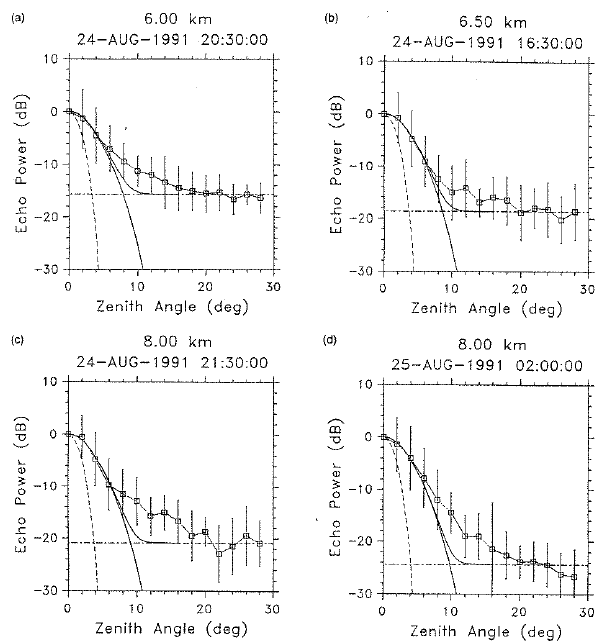
Fig. 11. Four comparisons between aspect sensitivity observations with the MU radar (squares with vertical bars indicating the stan- dard deviation of the variations during the averaging time) with the results Z(θ) of a model based on the hypothesis of layers with a surface corrugated by gravity waves (solid lines). The dashed and dot-dash lines indicate the squared MU radar antenna gain and the turbulent scattering level S , respectively. The values Z(θ) + S are also given in solid lines. For more details, see discussions in Sect. 6 (after Tsuda et al.,